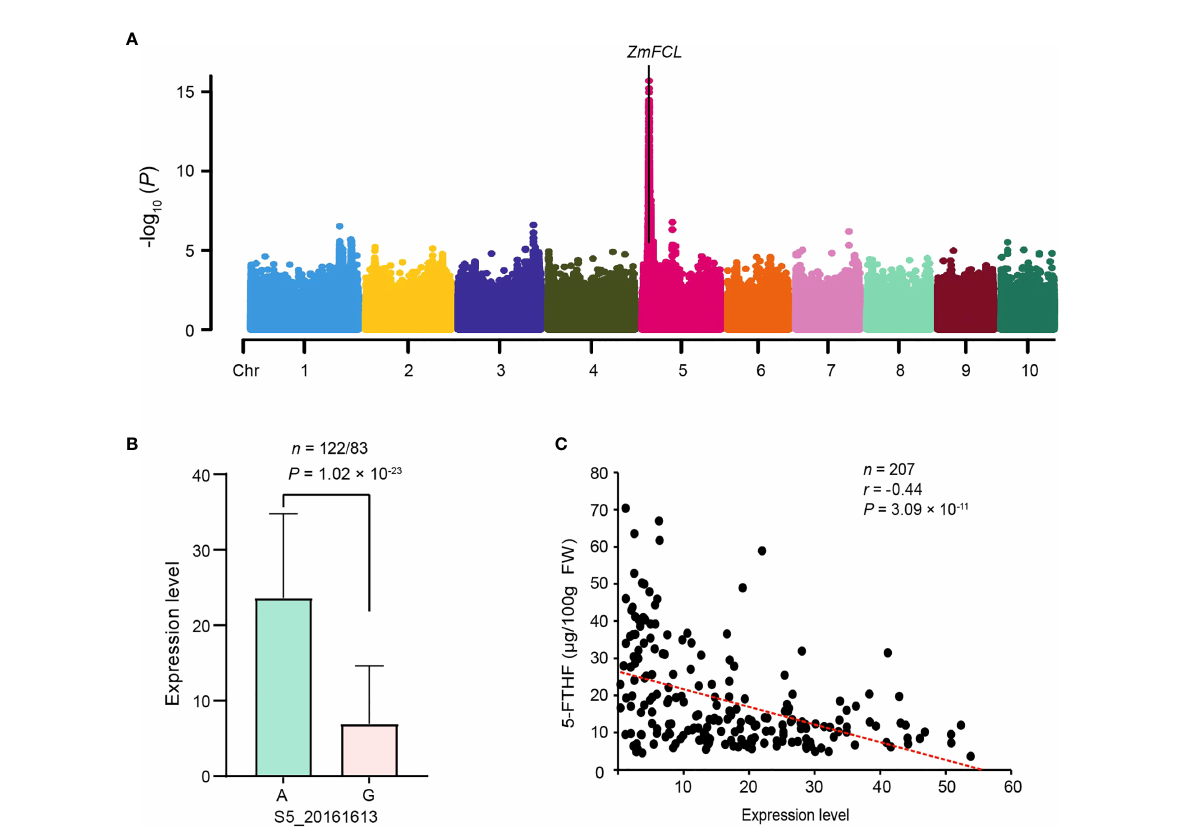
FIGURE 3 Expression analysis of ZmFCL . (A) Manhattan plot for the expression GWAS of ZmFCL with eQTL. (B) Comparison of ZmFCL expression between different alleles of the signi fi cant SNP (S5_20161613). The P value is based on a two-tailed t -test. n denotes the number of genotypes belonging to each allele group. (C) The correlation between the expression level of ZmFCL and 5-FTHF. The x axis represents the expression of ZmFCL in kernels collected at 15 DAP. The y axis represents the 5-FTHF. n denotes the number of inbred lines of sweet corn. The r value is a Pearson correlation coef fi